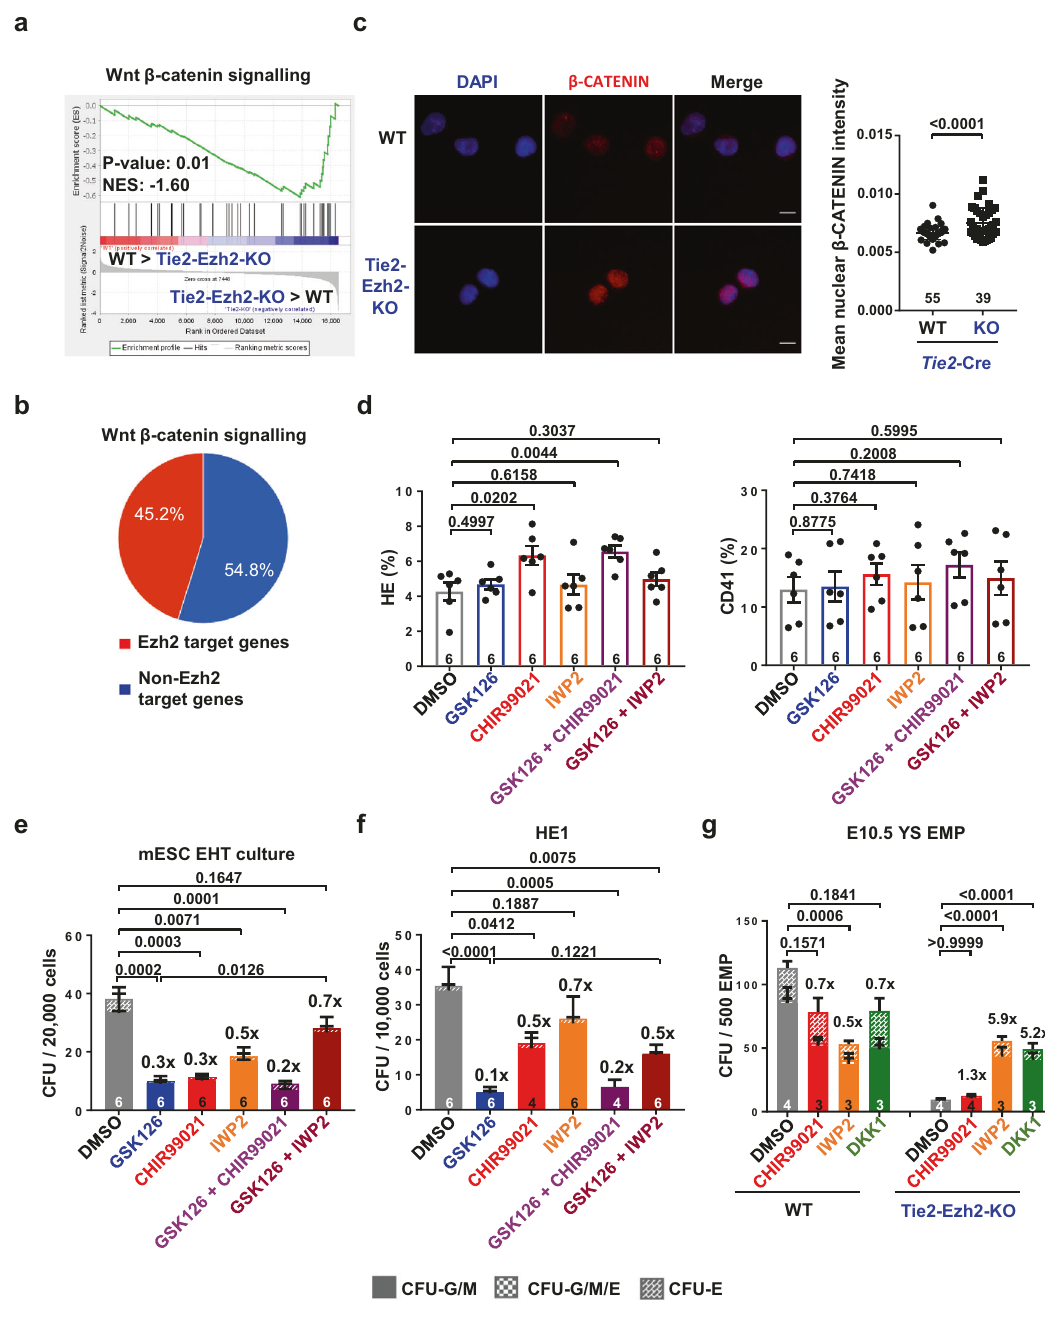
Fig. 4 Wnt signaling inhibition rescues the functional block of hematopoiesis created by inhibiting Ezh2. a GSEA comparing WT and Tie2-Ezh2-KO EMP for Wnt β -catenin signaling gene sets. b Proportion of Ezh2 target genes in Wnt signaling gene sets. c Representative immunostaining of E10.5 YS EMPs (2 independent experiments) using antibody against β -CATENIN (red). Nuclear is marked by DAPI staining (blue). Scale bars, 20 µ m. Mean nuclear β -CATENIN intensity was analyzed. Numbers of analyzed EMPs are indicated at the bottom of the graph. d , e FLK1 + hemangioblasts were cultured in EHT cultures with or without 1 μ M GSK126 at day 1 and 3 μ M CHIR99021 or 3 μ M IWP2 at day 2 (3 independent experiments). d Percentage of HE (TIE2 + KIT + ) and hematopoietic cells (CD41 + ) by FACS analysis at day 3. e Measurement of the hematopoietic output of DMSO, GSK126, CHIR99021 or IWP2 treated D3 cultures with CFU-C assay. f CFU-C assay of DMSO, GSK126, CHIR99021 or IWP2 treated HE1 (4 independent experiments). The numbers of biological replicates are indicated at the bottom of each column in e , f . g Explant culture of DMSO, 3 μ M CHIR99021, 3 μ M IWP2 or 200 ng/ml DKK1 treated E10.5 YS EMPs (2 independent experiments). Numbers of analyzed YS are indicated at the bottom of each column. Two-tailed t -test was used to assess statistical signi fi cance in c , d . Two-way ANOVA was used to assess statistical signi fi cance in e , f , g . Error bars represent ± or +